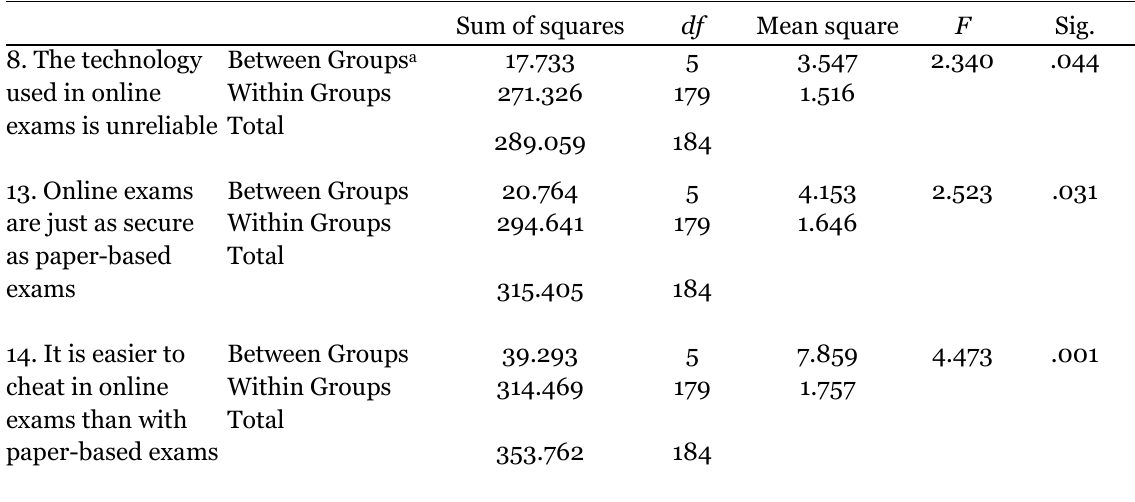
Results of the One-Way ANOVA Test on Turkish Learners’ Perception by Academic Major